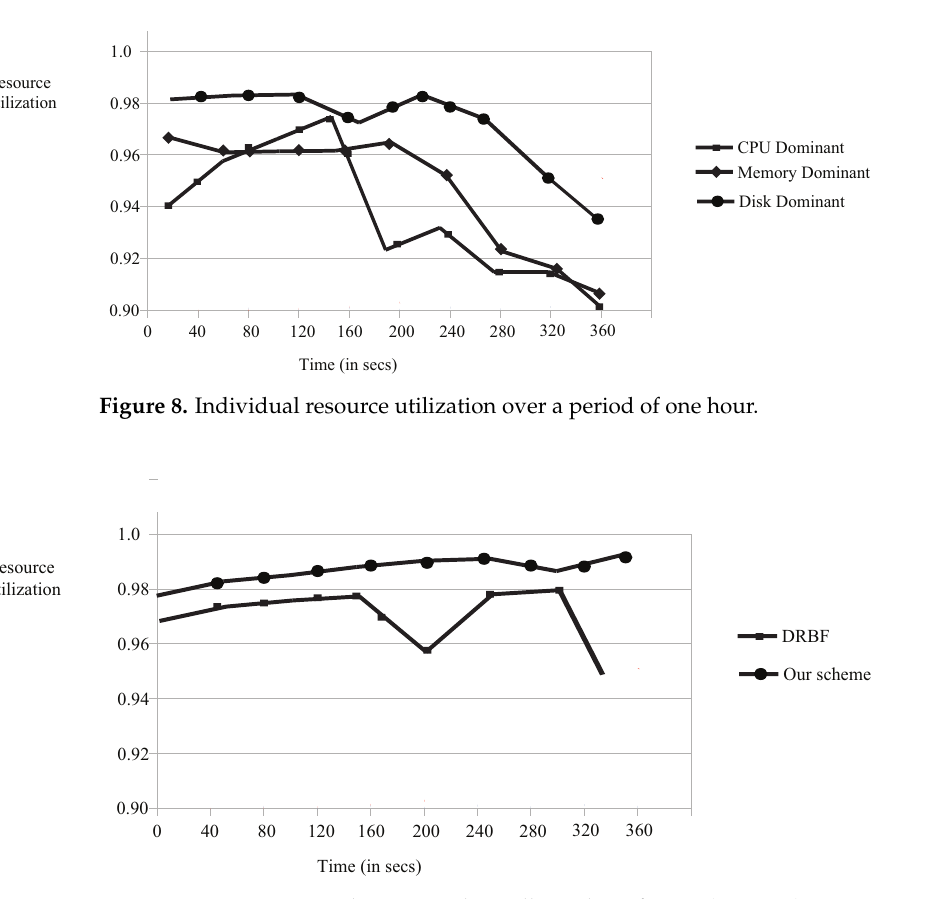
Figure 9. Average resource utilization with small number of users (up to